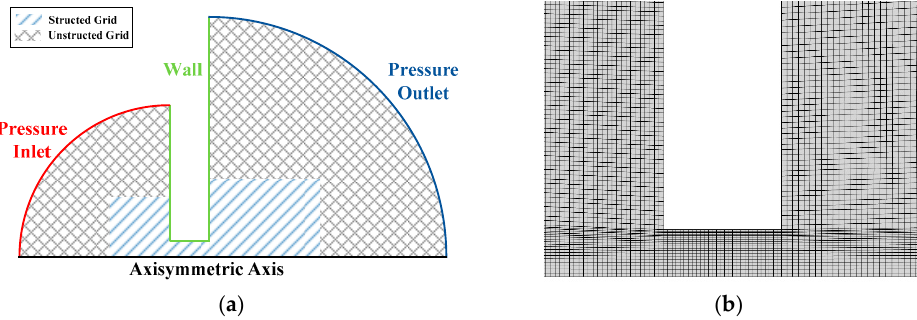
Figure 3. Grid model. ( a ) schematic diagram of the grid model; ( b ) grid around the leak hole (take the 2 mm leak hole model as example).